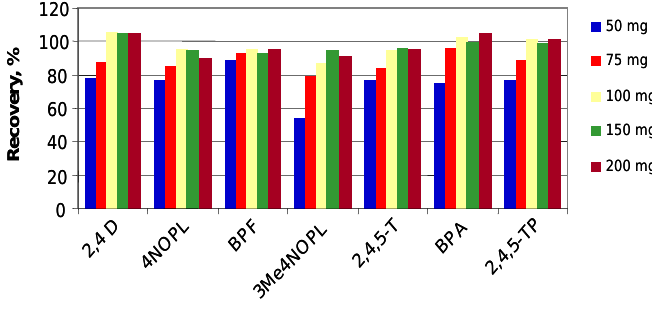
Figure 5. Influence of polymer mass on the recoveries of the fraction eluted from the bisphenol-A-MIP. Sample: 5 mL of toluene with 100  g L −1 of each compound. Washing and elution steps as in Figure